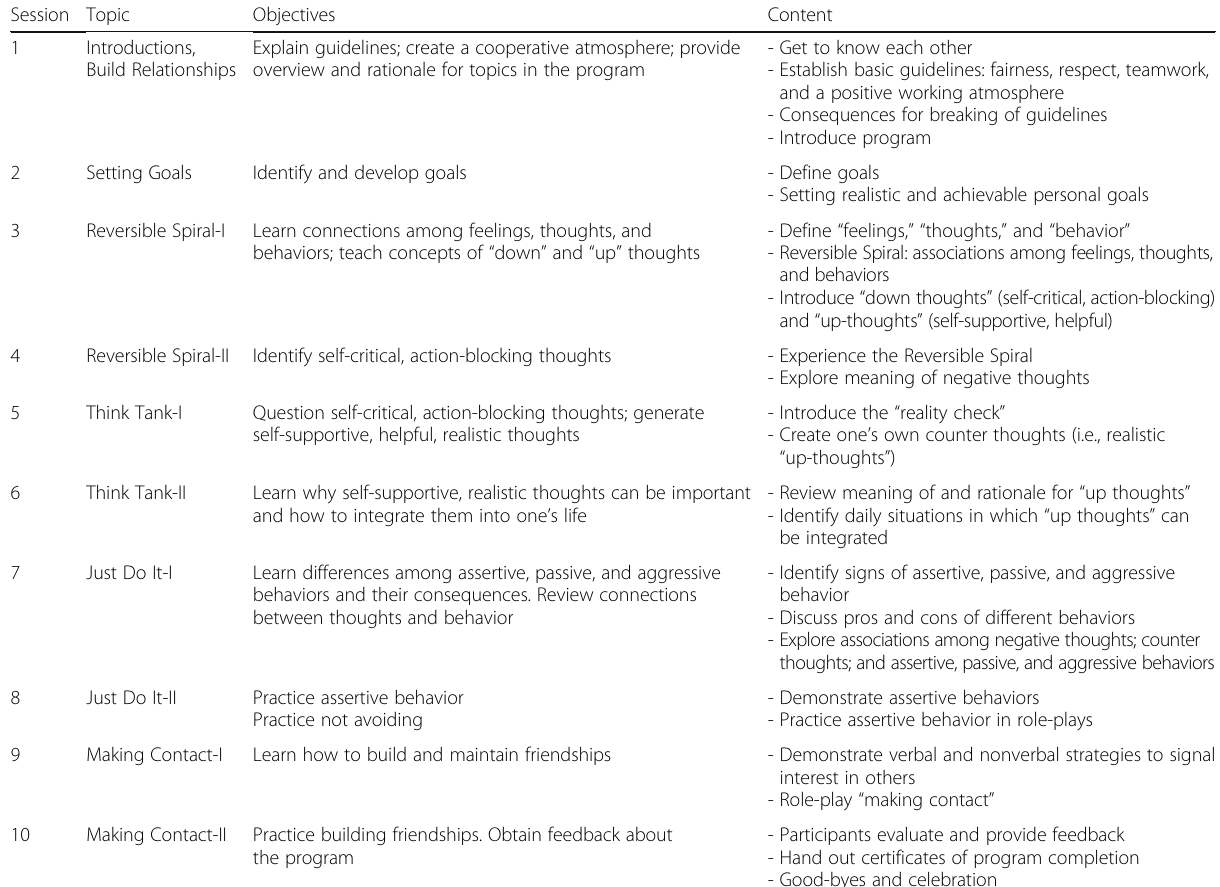
Table 2 Content of LARS&LISA Session Topic Objectives